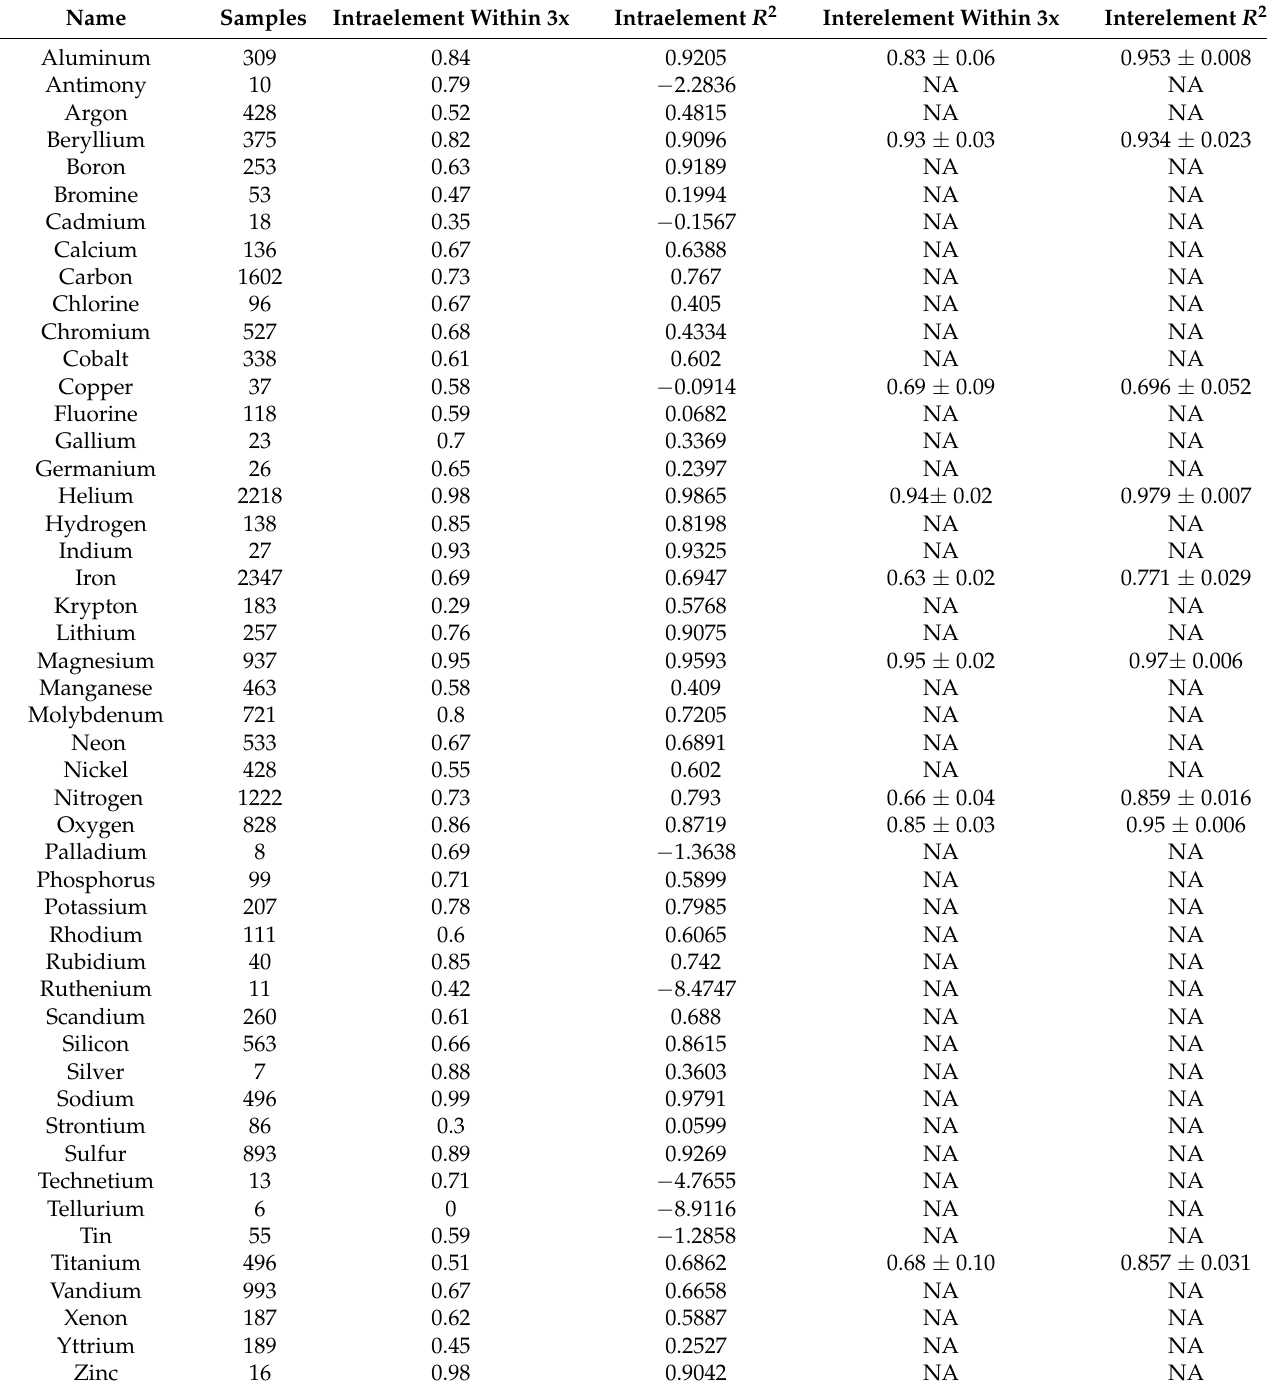
Table A1. Performance metrics for all elements